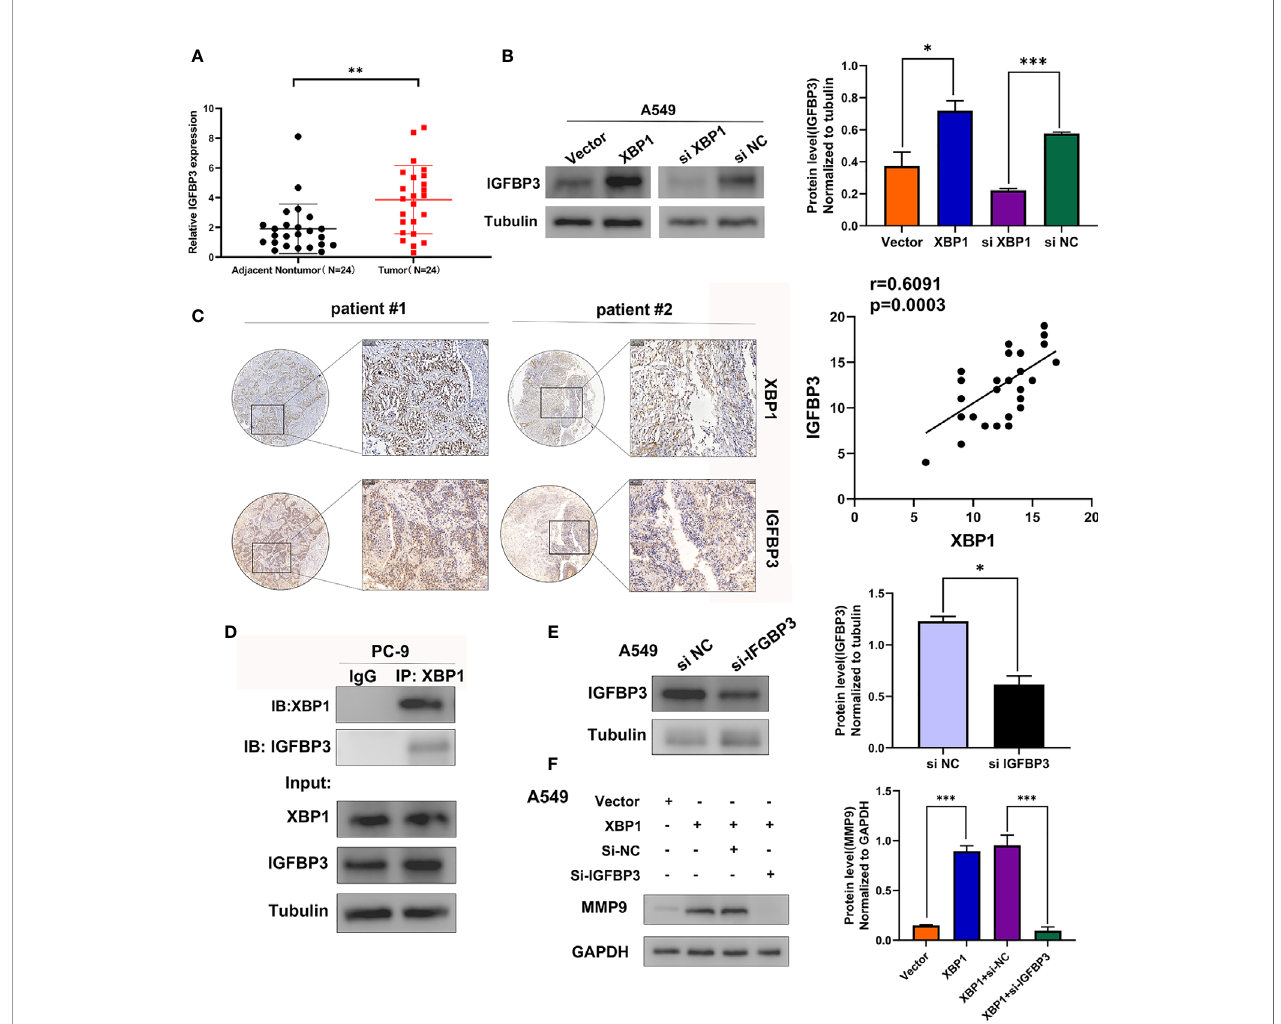
FIGURE 5 | XBP1 interacts with IGFBP3 and upregulates the protein level of IGFBP3. (A) Representative statistics analysis of IGFBP3 mRNA expression levels in 24 NSCLC tumor tissues and adjacent nontumor lung tissues using qRT-PCR. (B) Expression of IGFBP3 in transfected with XBP1 and negative control cells, si-XBP1 and negative control cells as detected by western blot. (C) Representative immunohistochemically stained images of NSCLC tissues using the anti-XBP1 and anti- IGFBP3 antibodies. Areas in the black squares are magni fi ed in the right slide panels. (D) Exogenous interaction between XBP1 and IGFBP3 in PC-9 cells. (E) Expression of IGFBP3 in transfected with si-IGFBP3 and negative control cells as detected by western blot. (F) Expression of MMP-9 in transfected negative control, XBP1, both XBP1 and si-IGFBP1 or both XBP1 and si-NC. Data were represented as the mean ± SEM of three independent experiments. * P < 0.05, ** P < 0.01, *** P <